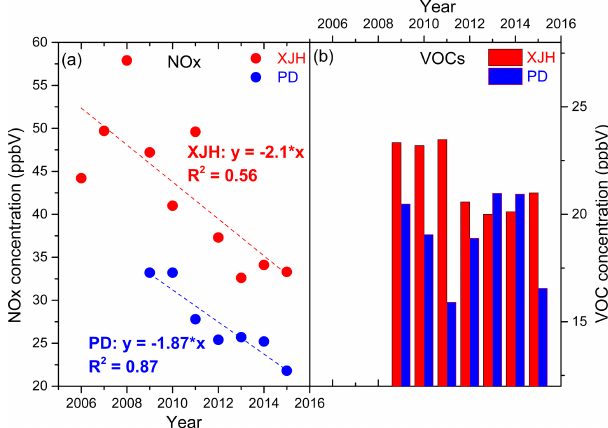
Figure 3. The mean annual concentrations (ppbv) of (a) NO x (dots) and (b) VOCs (bars) from 2006 to 2015 at the downtown site XJH and the sub-urban site PD. The NO x concentrations at XJH and PD both present obvious decreasing trends with 2.1 and 1.87ppbvyr − 1 , while the VOC concentrations at both sites present no clear interan- nual